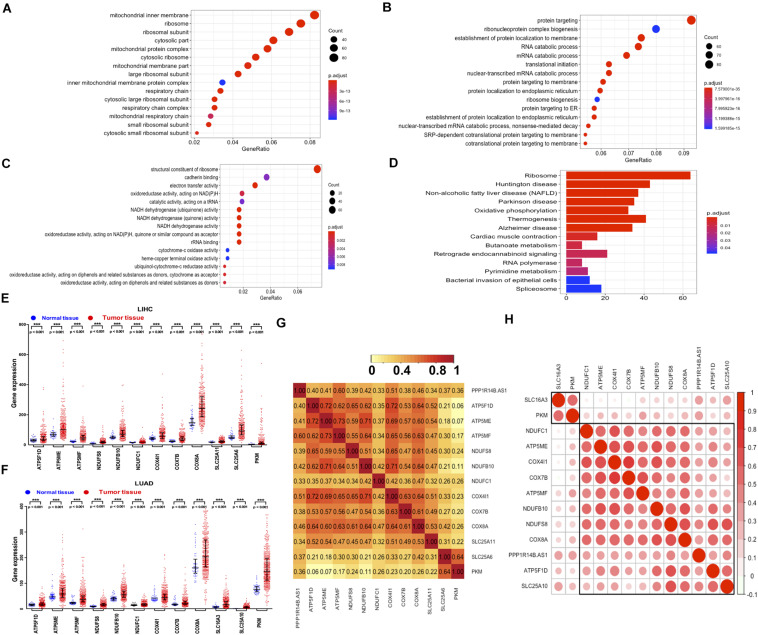
PPP1R14B-AS1 and its correlated genes participated in regulating mitochondrial function and tumor metastasis. (A–C) GO enrichment analyses of PPP1R14B-AS1 and its co-expressed genes in LIHC, cut-off values as absolute Pearson correlation coefficients > 0.3 and p < 0.05. (D) KEGG enrichment analyses of PPP1R14B-AS1 and its co-expressed genes in LIHC, cut-off values as absolute Pearson correlation coefficients > 0.3 and p < 0.05. (E,F) Expression of typical genes related to PPP1R14B-AS1 in patients with LIHC or LUAD, Mann–Whitney test. ***p < 0.001. (G,H) Correlation heatmaps of typical genes related to OXPHOS and associated with PPP1R14B-AS1 in LIHC and LUAD.